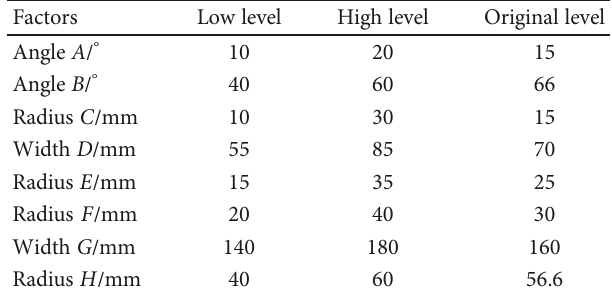
Figure 3: Comparison of extrusion result between simulation and test. Table 2: PB design factors and levels.